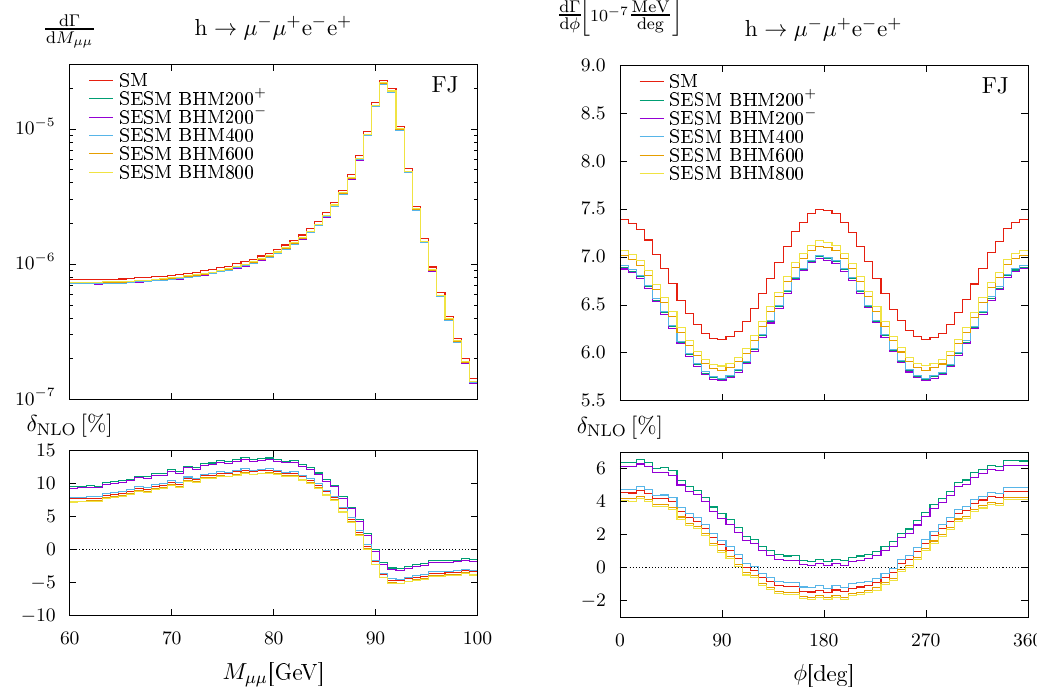
Figure 21 . Invariant-mass and angular distributions for the neutral-current decay into leptons h ! (cid:22) (cid:0) (cid:22) + e (cid:0) e + , in the FJ renormalization scheme for the various SESM scenarios. angle (cid:30) , which is de(cid:12)ned as the angle between the decay planes of the two intermediate